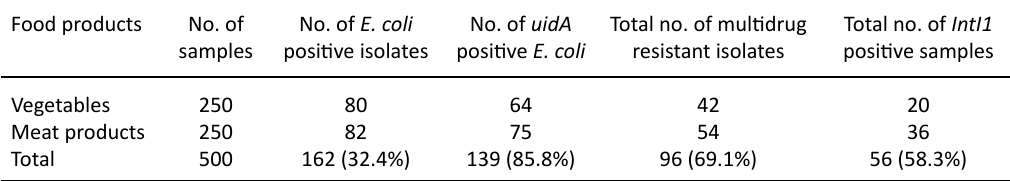
table 3. A detailed positive report of E. coli isolated from ready-to-eat food products Food products